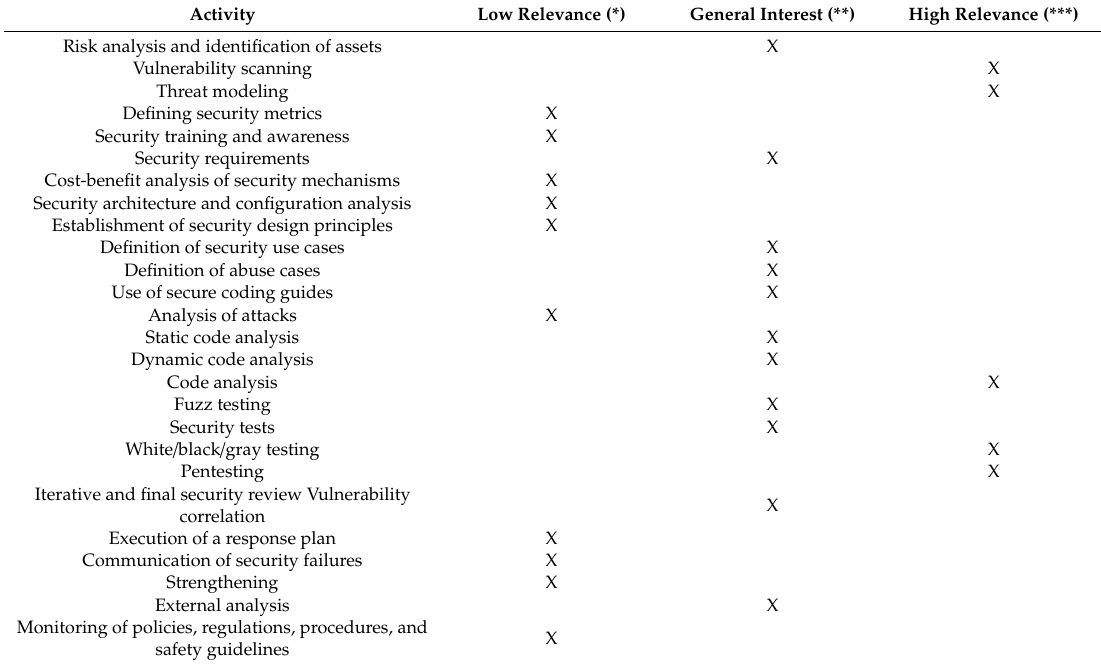
Table 5. Security